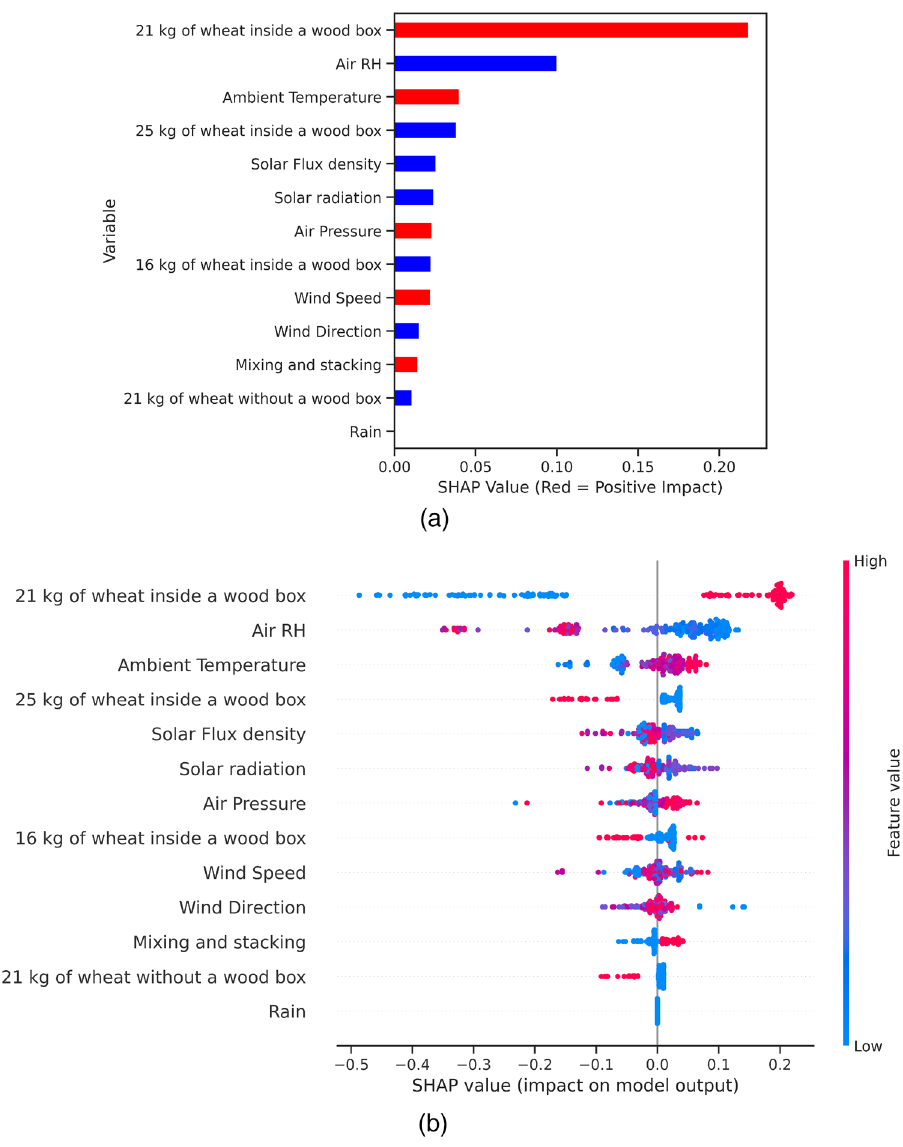
Figure 5. ( a ) Feature importance plot, and ( b ) SHAP summary plot showing feature influence on wheat grains storage